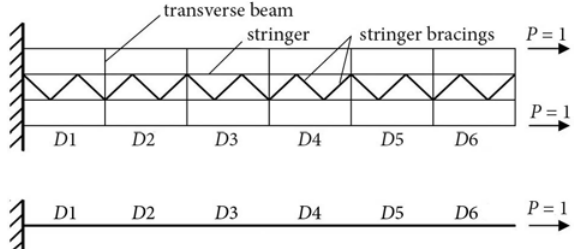
Fig. 4. Additional analysis to set equivalent cross-sections of truss flange members